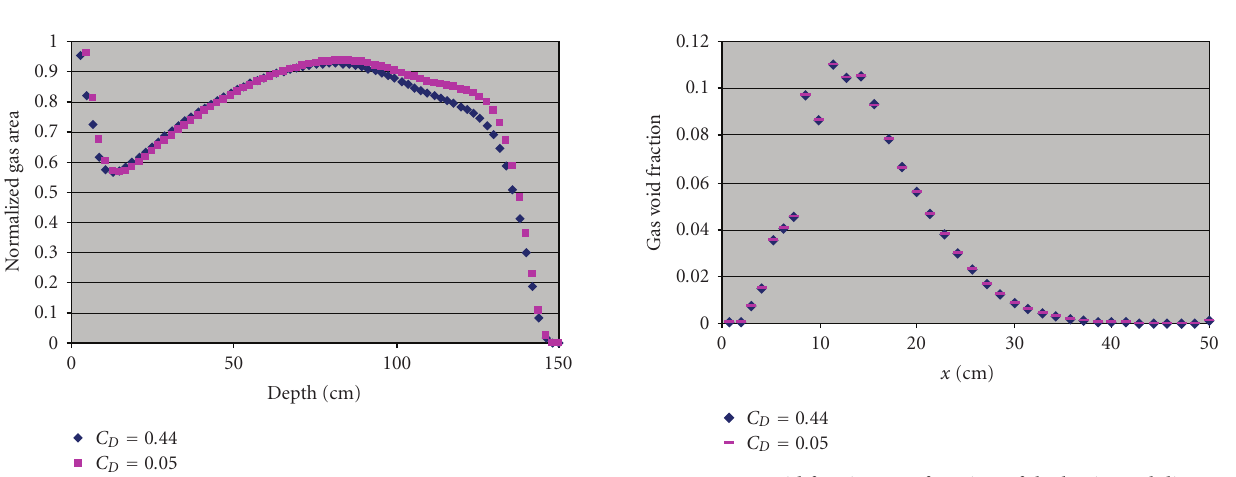
Figure 6: Gas void fraction as a function of the horizontal distance to the jet axis, 30 cm below the water level. The values for C D = 0 . 44 (blue) and C D = 0 . 95 (mangenta) di ff er hardly.